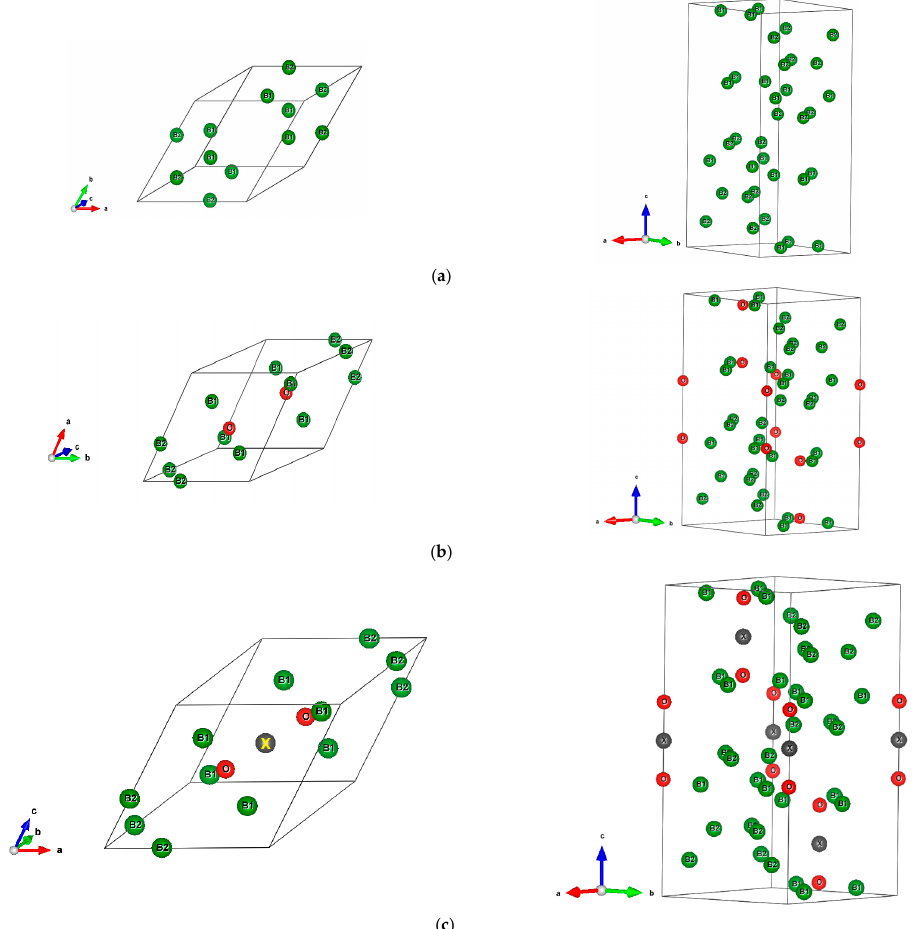
Figure 1. (color). Representation of the B 12 -based structures in rhombohedral (left) and hexagonal (right) settings, with 1 and 3 formula units (FU) respectively. ( a ) α -B 12 , ( b ) B 12 O 2 , ( c ) Proposed B 12 O 2 :X, with X representing a generic interstitial at the central void (X = B, C, N, and O).